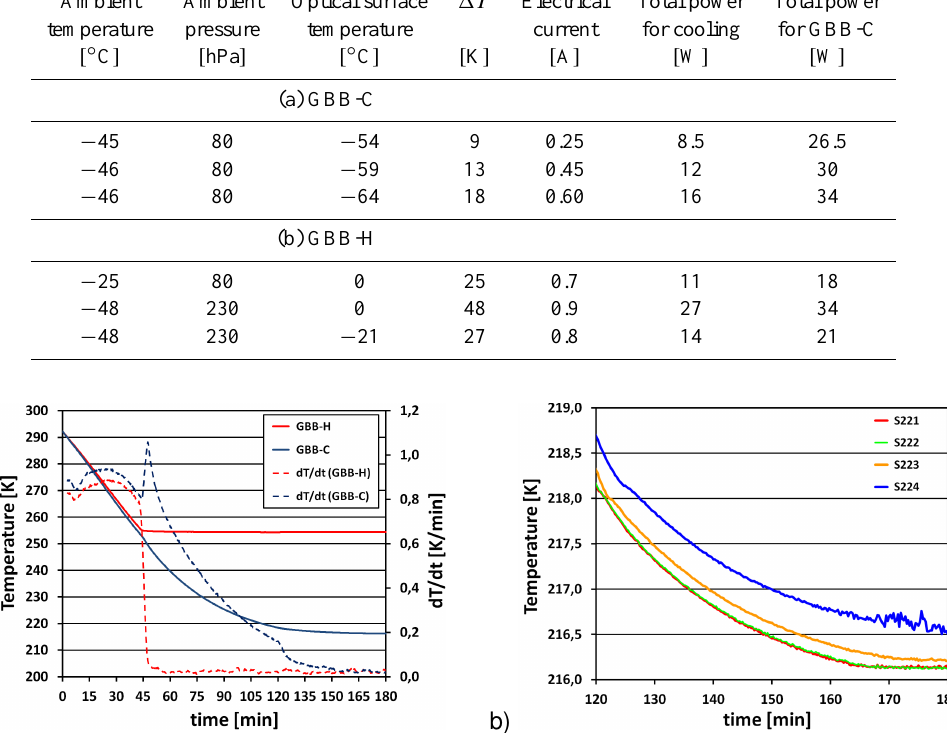
Fig. 14. GBB-HALO flight simulation test: (a) GBB-C temperature (T-sensor S110) and GBB-H temperature (T-sensor S210) during the first three hours of the flight, (b) thermal behaviour of GBB-C optical surface after two flight hours.